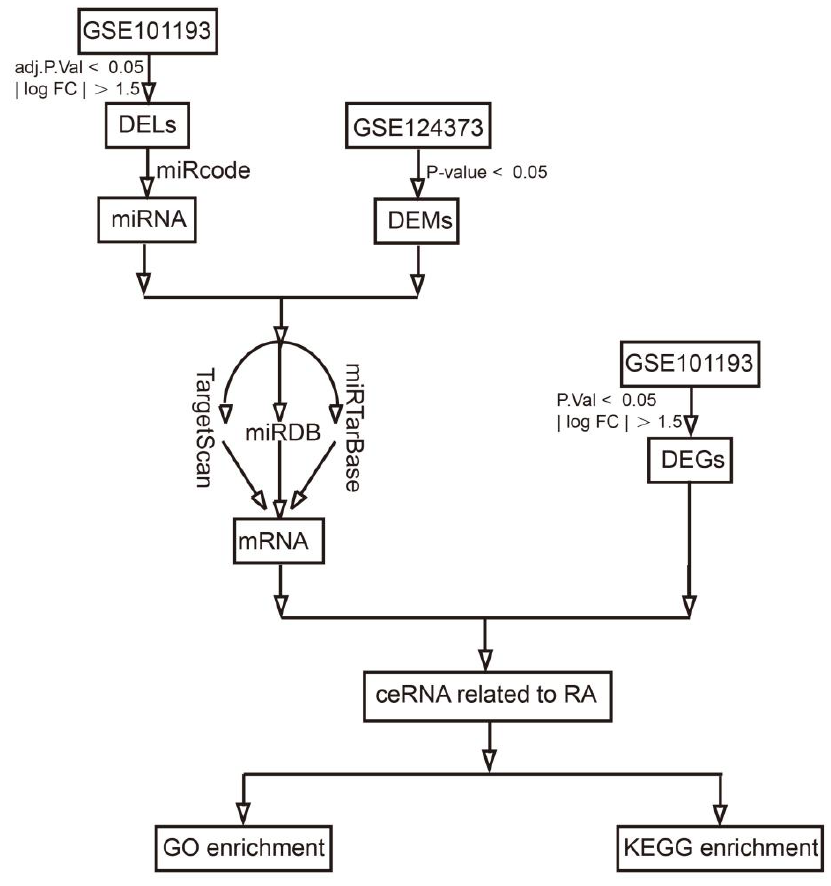
Figure 1. Workflow of this study.